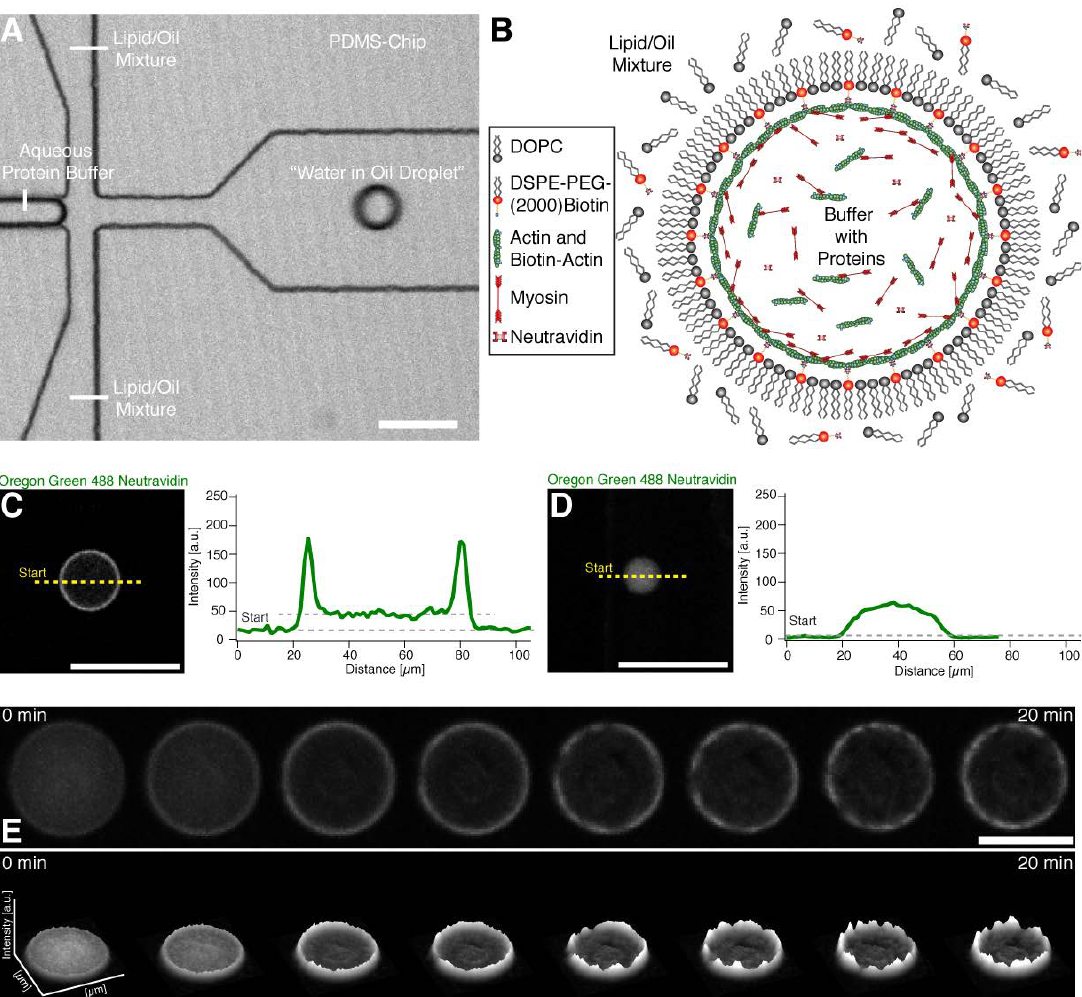
Figure 1 . Encapsulation and actin cortex formation inside water in oil droplets. ( A ) Confocal image of a PDMS chip where the encapsulation of the buffer-protein system (see ( B )) and formation of the water in oil droplet is shown (Movie S1). (B) Illustration depicting the formation of an actomyosin cortex. Neutravidin with its four binding sites may bind several actin filaments and biotinylated lipids. ( C ) Confocal image of the equatorial plane of a droplet with a lipid monolayer containing biotinylated lipids showing that encapsulated Oregon green labeled neutravidin binds to the lipid monolayer. Line profile of the fluorescence signal of the Oregon green labeled neutravidin shows two peaks which indicate binding of the neutravidin to the lipid monolayer interface of the droplet (right). ( D ) In contrast, Oregon green labeled neutravidin does not bind to the lipid monolayer and is distributed throughout the lumen of the droplet in the absence of biotinylated lipids. The fluorescence line profile shows no peaks in the absence of biotinylated lipids indicating the absence of unspecific binding to the lipid monolayer (right). ( E ) Confocal time-lapse images of encapsulated Alexa-488 labeled actin and myosin motors in the presence of ATP at the droplet equator plane. The formation of an actin cortex and actomyosin clusters is shown (upper row) (Movie S2). The respective fluorescent intensity profile indicates the formation of actomyosin clusters and shows their dynamics (lower row). Scale bars, 100 µm.